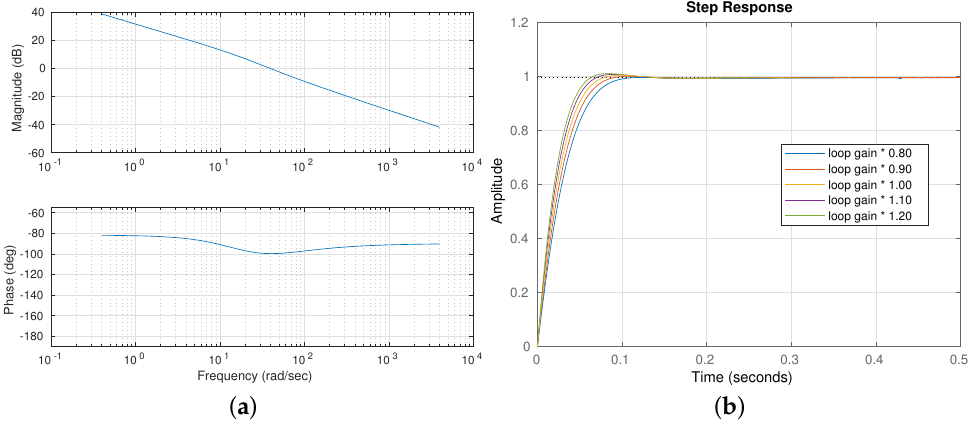
Figure 14. Open loop Bode diagram ( a ) and closed loop time response ( b ) for the fractional order (FOPI) controller.